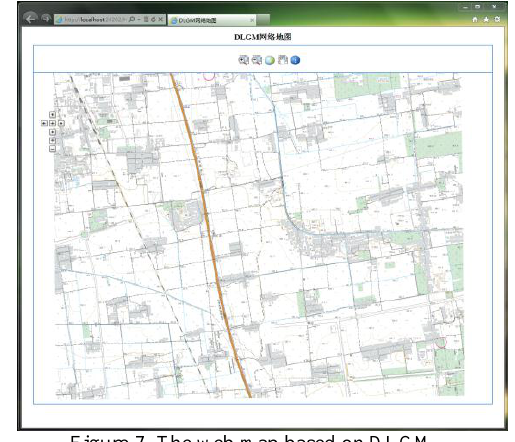
Figure 7. The web map based on